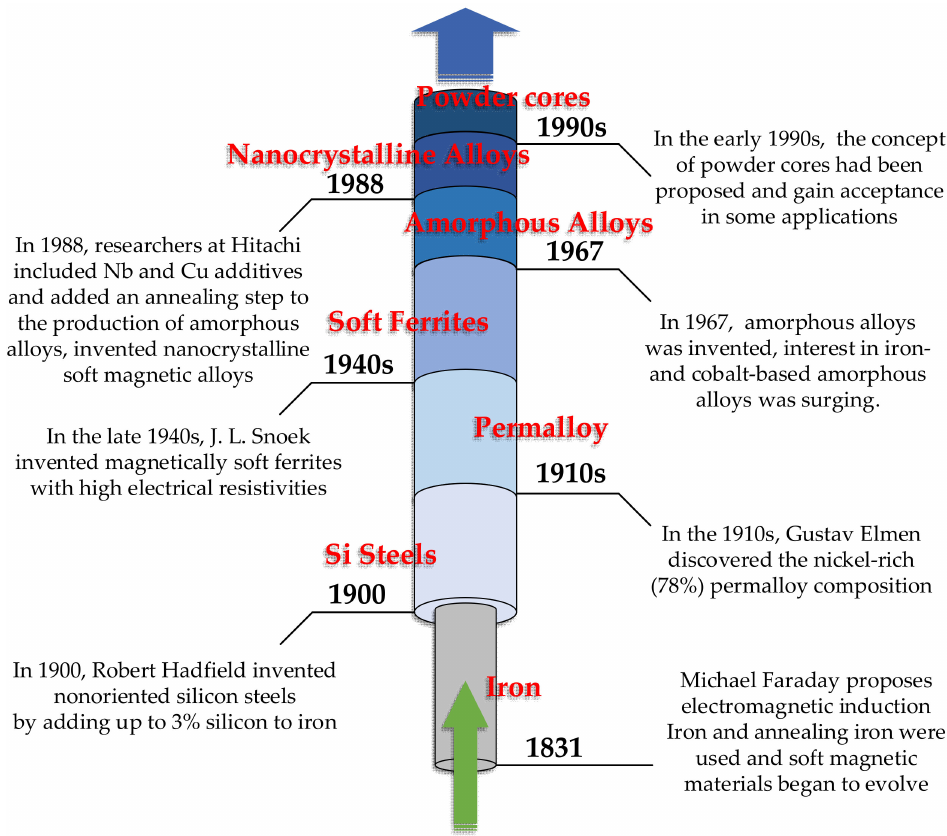
Figure 8. Research progress and a brief history of soft magnetic